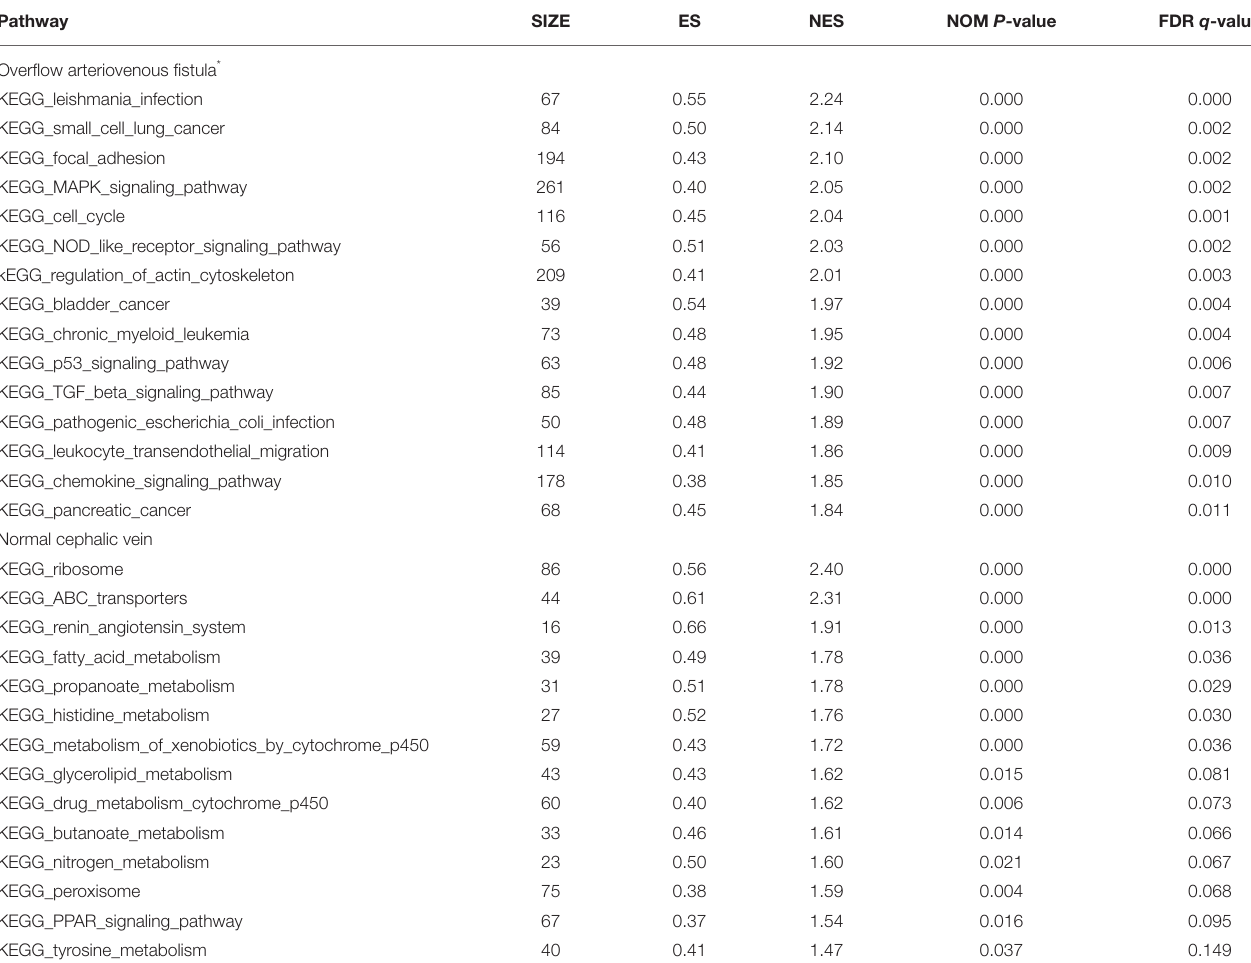
TABLE 2 | The significantly enriched KEGG pathway from GSEA. Pathway SIZE ES NES NOM P -value FDR q -value Overflow arteriovenous fistula *